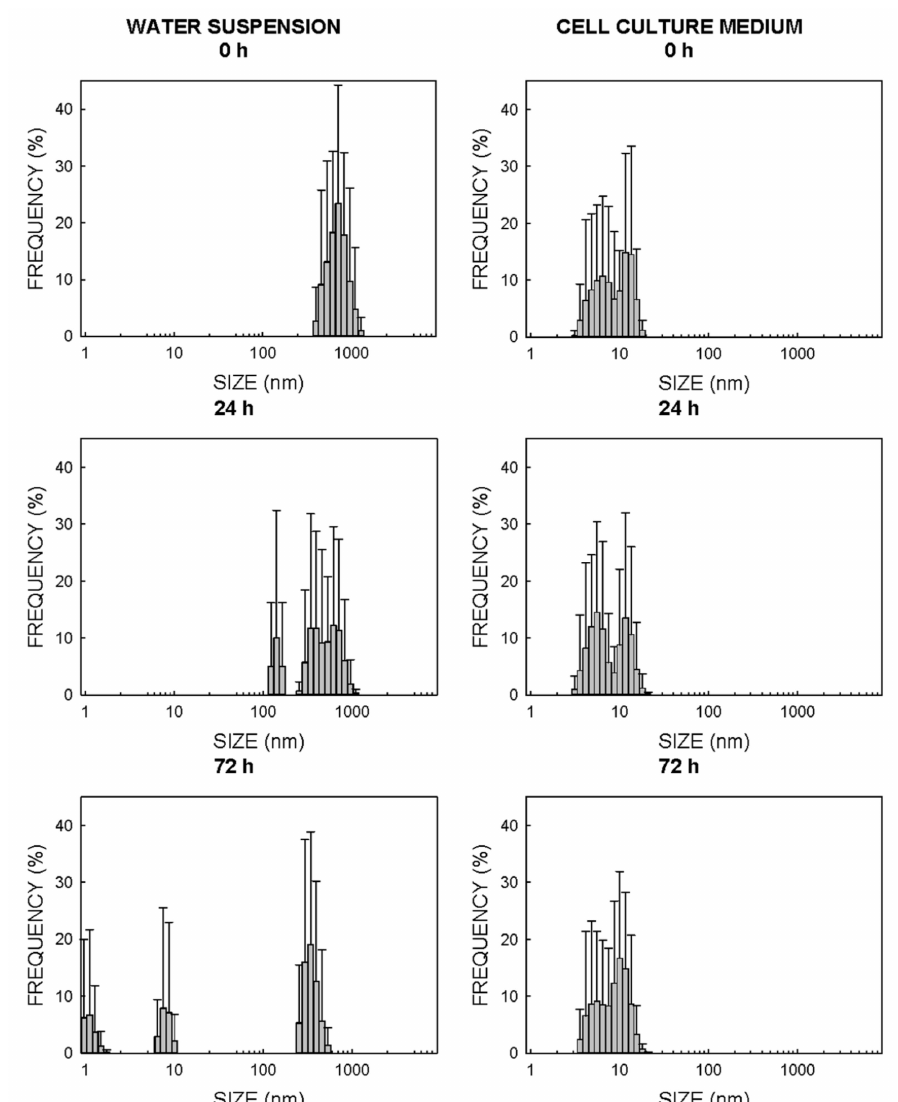
Figure 2. Analysis of the size and distribution of ZnO-NPs in water ( left panels ) and the cell culture medium ( right panels ). Size was determined by DLS. The cell culture medium was the Roswell Park Memorial Institute (RPMI) cellular medium supplemented with 10% fetal bovine serum